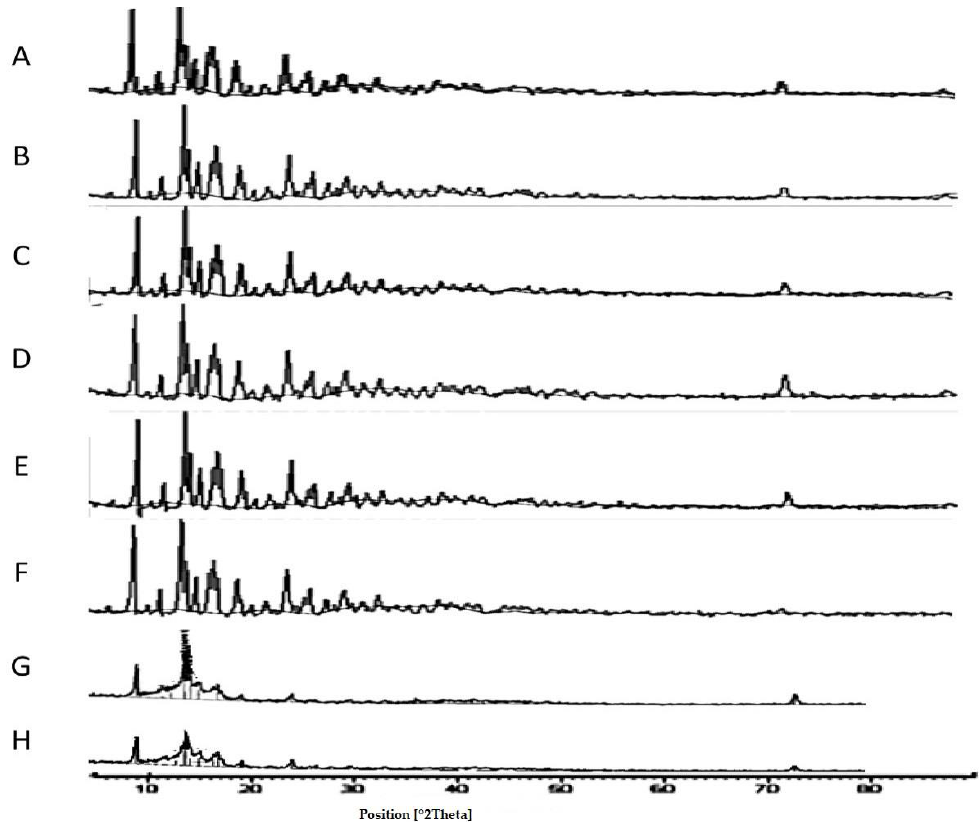
Figure 4. XRD scans of different TAA formulations. ( A ) Micronized TAA raw material unprocessed and ( B ) 1%, ( C ) 1.5%, ( D ) 2%, ( E ) 2.5%, and ( F ) 3% ( w / v ) TAA systems spray-dried from 90% ( v / v ) ethanol, ( G ) 1% TAA system spray-dried from 70% ( v / v ) ethanol, and ( H ) 1% TAA system spray-dried from 80% ( v / v ) ethanol.